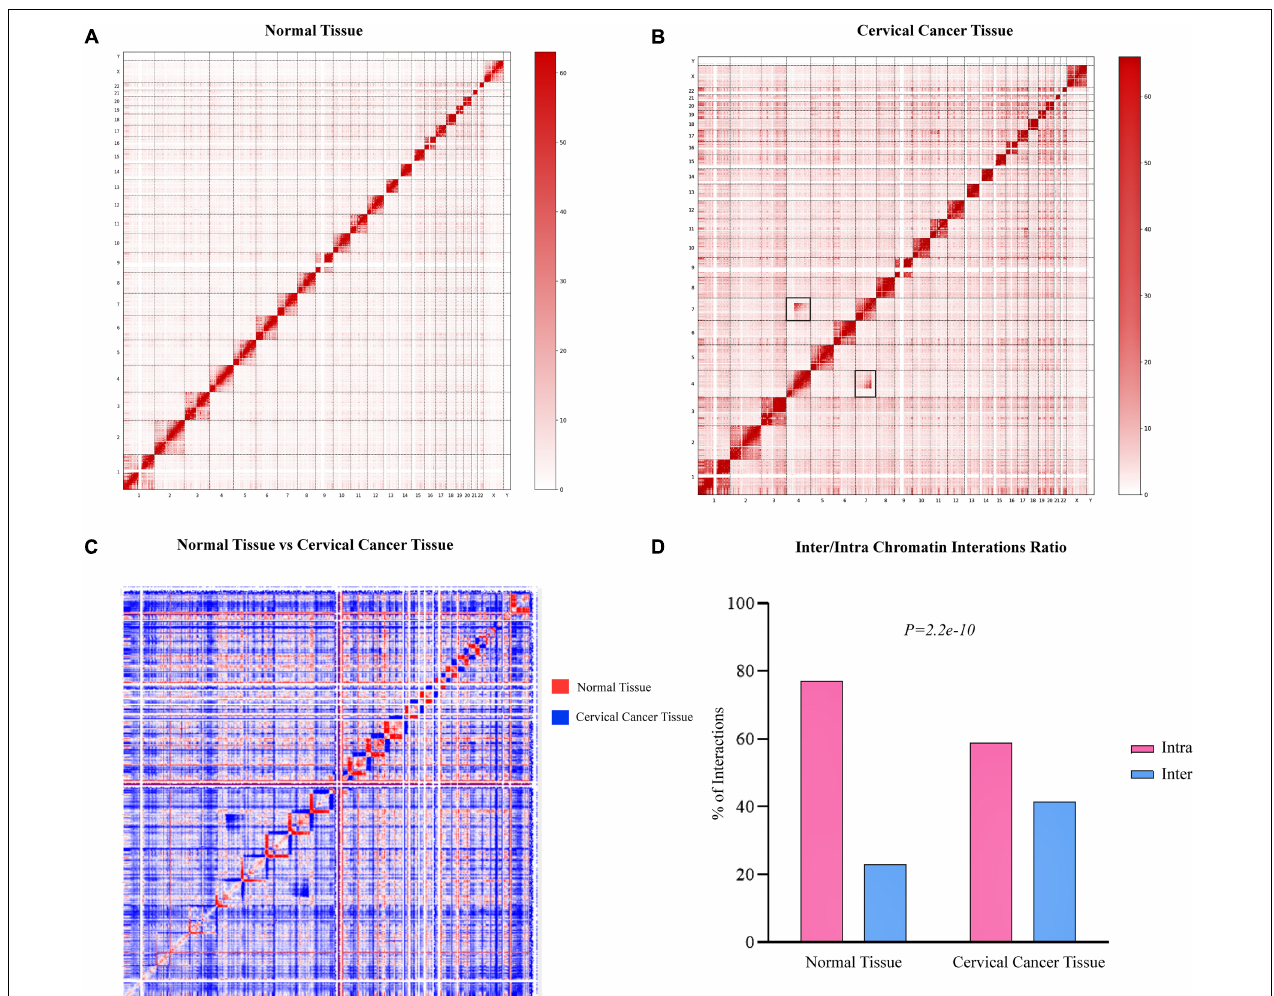
FIGURE 1 | Hi-C data showing genome-wide variations in cervical cancer 3D-genome. Genome-wide Hi-C interaction map at 1 Mb resolution. Heatmap representing normal (A) and cervical cancer (B) tissues chromosomal interactions, respectively. Black squares indicate the inter-chromosomal rearrangements. (C) A heatmap shows the difference of higher order chromatin interactions between normal tissue (red color) and cervical cancer (blue color) tissue Hi-C data. (D) Hi-C quality analysis indicating the number of inter- and intra-chromosomal interactions between both samples. Red bars depict intra-chromosomal interactions, while sky-blue bars denote inter-chromosomal interactions.